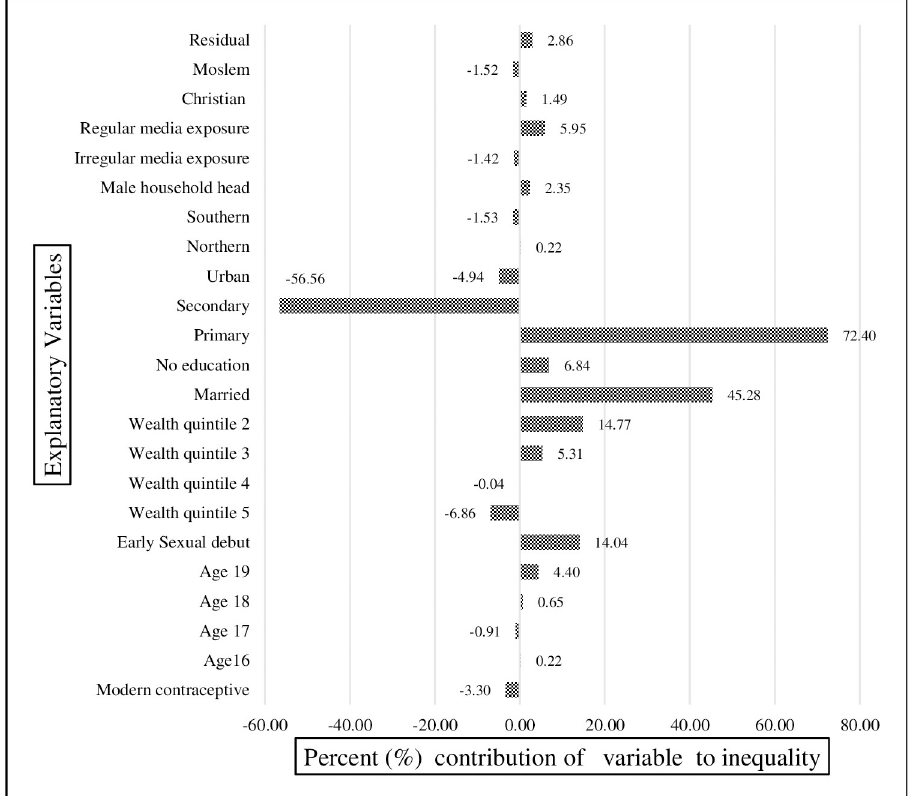
Fig 7. Decomposition of the concentration index for year 2010. Constructed by authors from MDHS 2004, 2010,